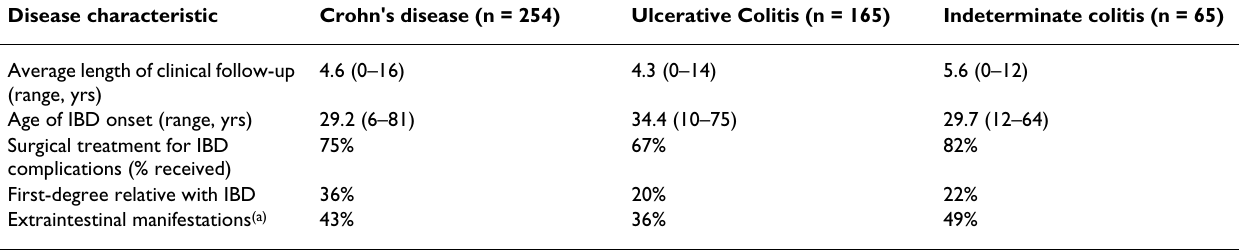
Table 1: General characteristics of the studied inflammatory bowel disease (IBD) population. Disease characteristic Crohn's disease (n =